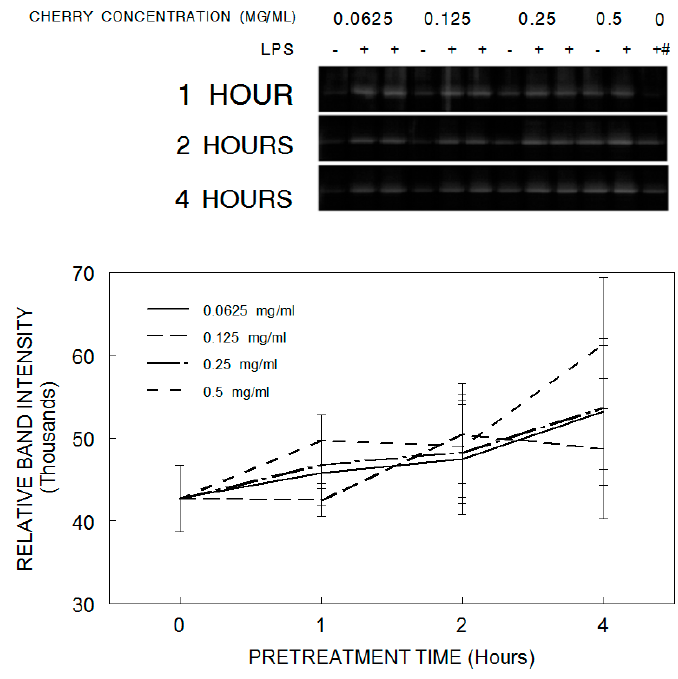
Figure 2. Expression of inducible nitric oxide synthase (iNOS) in HAPI microglial cells pretreated with tart cherry powder (0.062, 0.125, 0.250, or 0.500 mg/mL) for 0 (LPS only/alone control), 1, 2, or 4 h and stimulated overnight with lipopolysaccharide (LPS, 100 ng/mL). Quantitative measurements were made based on the Western blots, and are expressed as mean ± SEM for the immunoreactive band density. Each tart cherry pretreatment was compared against LPS treatment alone, and comparative post hoc analyses were made by Tukey’s HSD. # column represents blots for 0 cherry with either no LPS (in the 1 h row) or LPS (in the 2 and 4 h row).